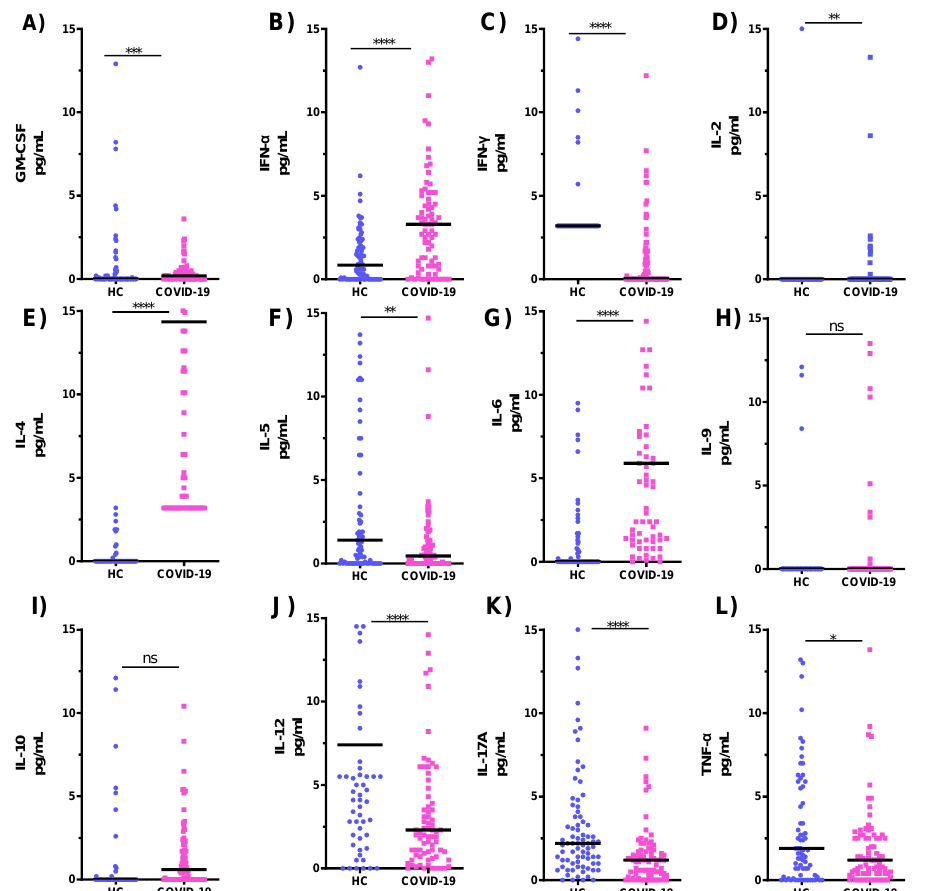
Figure 3. Cytokine profiles in serum samples from healthy subjects and patients in the COVID-19 intensive care unit. * p < 0.05 , ** p < 0.01 , *** p < 0.001 , **** p < 0.0001 refers to the statistical differences. HC: healthy controls; ns: not significant.